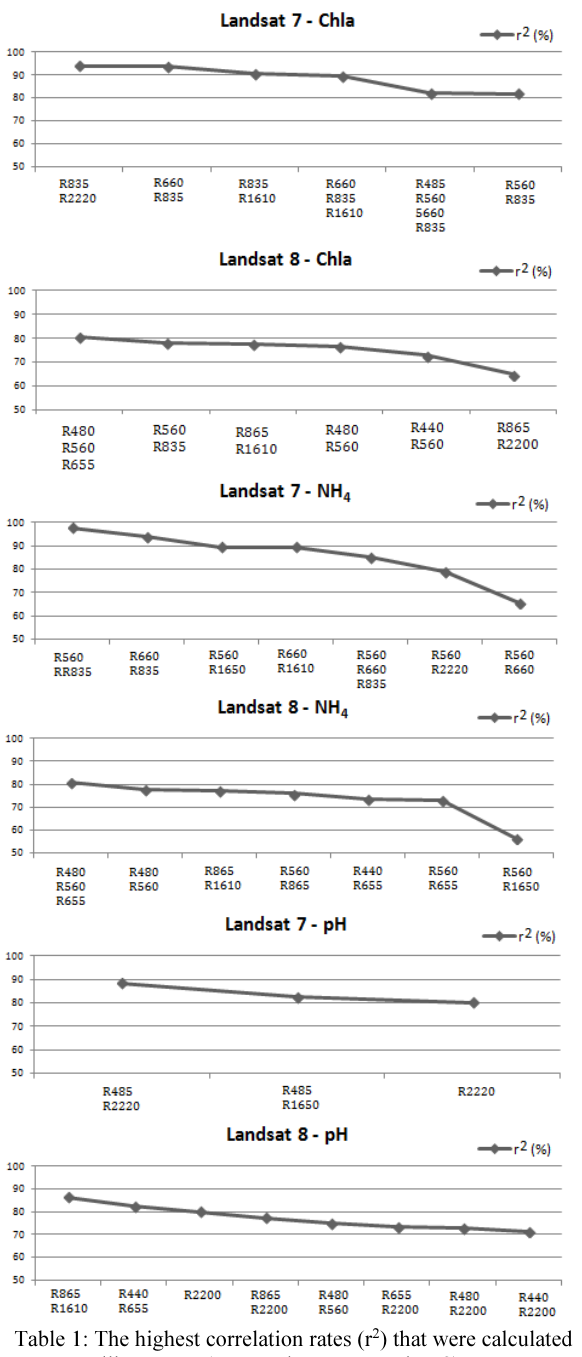
Table 1: The highest correlation rates (r 2 ) that were calculated per satellite sensor ( i.e, Landsat 7 or Landsat 8), per water quality indicator ( i.e, pH, Chla, etc) and per spectral band combination ( e.g.,